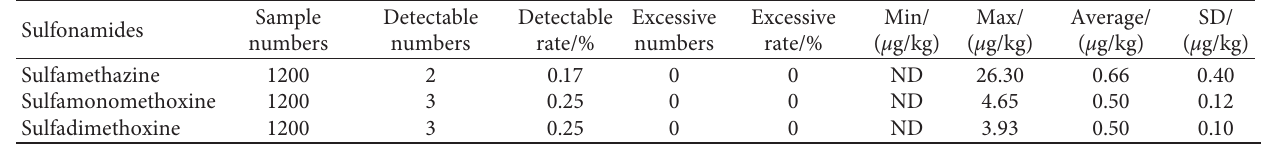
Table 3: Monitoring result of sulfonamide residues in animal products.